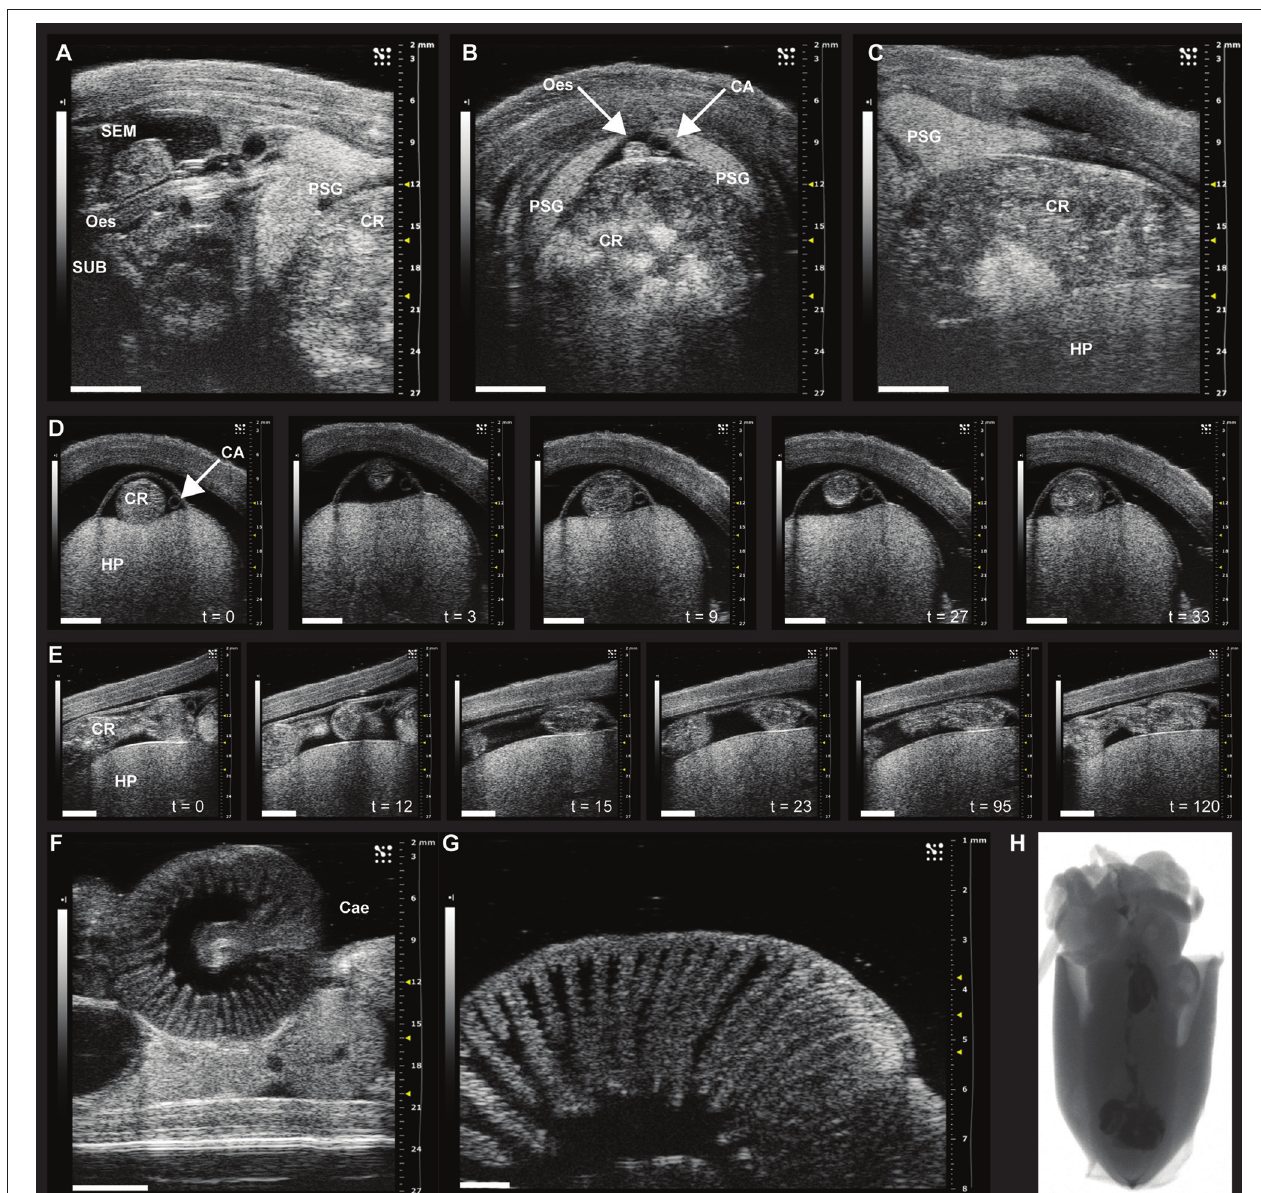
FIGURE 1 | Sonographic scanning of the digestive tract of Octopus vulgaris (A–G) and X-ray imaging in juvenile S. officinalis (H) . (A–G) The digestive tract of O. vulgaris as it appears during ultrasound examination (VEVO 2100, VisualSonics). (A–C) The anterior part of the digestive system (note the crop full of food) and its relationship to other parts within the mantle. (A) Ultrasound examination in the longitudinal plane with supra- (SEM) and sub-oesophageal masses (SUB, sagittal view) and the esophagus (Oes) and the crop (CR, on the right). The posterior salivary glands (PSG) are also clearly identifiable. (B) Sonographic scanning using a transverse plane reveals a distended crop (CR) full of food, the esophagus (Oes), and the cephalic aorta (CA) lying on its dorsal surface between the posterior salivary glands (PSG). (C) Sonographic examination (longitudinal plane) showing one posterior salivary gland (PSG) with its typical leaf-shaped appearance, the distended crop (CR), and the hepatopancreas (HP), ventrally. (D) A sequence of frames from the sonographic examination (transversal plane) of the octopus digestive tract octopus reveals the crop of an animal fed 6 h before the ultrasound scan (about 30 s); the peristaltic motility of the crop is evident through the sequence of snapshots (from t = 0 to 33 s) with contractions and relaxations moving the crop contents. (E) The sequence of frames taken from the same animal during ultrasound examination in the longitudinal plane identifies contraction and relaxation of the crop dividing the bolus. (F) The caecum with its characteristic spiral organization as it appears during sonographic scanning. (G) High resolution (48 MHz) ultrasound scanning of the caecum showing the “villi-like” structures. (H) X-ray imaging of food labeled with contrast medium (barium sulfate) to monitor the course of digestion in juvenile S. officinalis . Scanning performed with a Kodak DXS-4000 Pro system on anesthetized individual. CA, cephalic aorta; Cae, caecum; CR, crop; Oes, esophagus; HP, hepatopancreas; PSG, posterior salivary gland; SEM, supra-oesophageal mass; SUB, sub-oesophageal mass. Images provided here resulted from examinations carried out in compliance with local regulations, and for veterinary purposes. Scale bar, A–F : 5 mm; G : 1